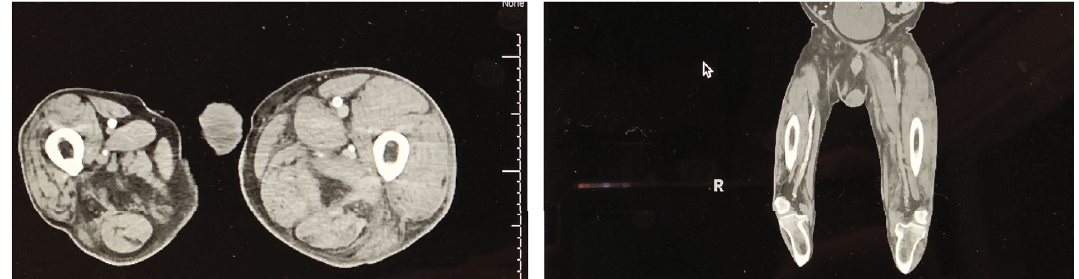
Figure 2: Computed tomography angiography showing the lack of arterial blood fl ow in the left super fi cial femoral and proximal popliteal arteries.